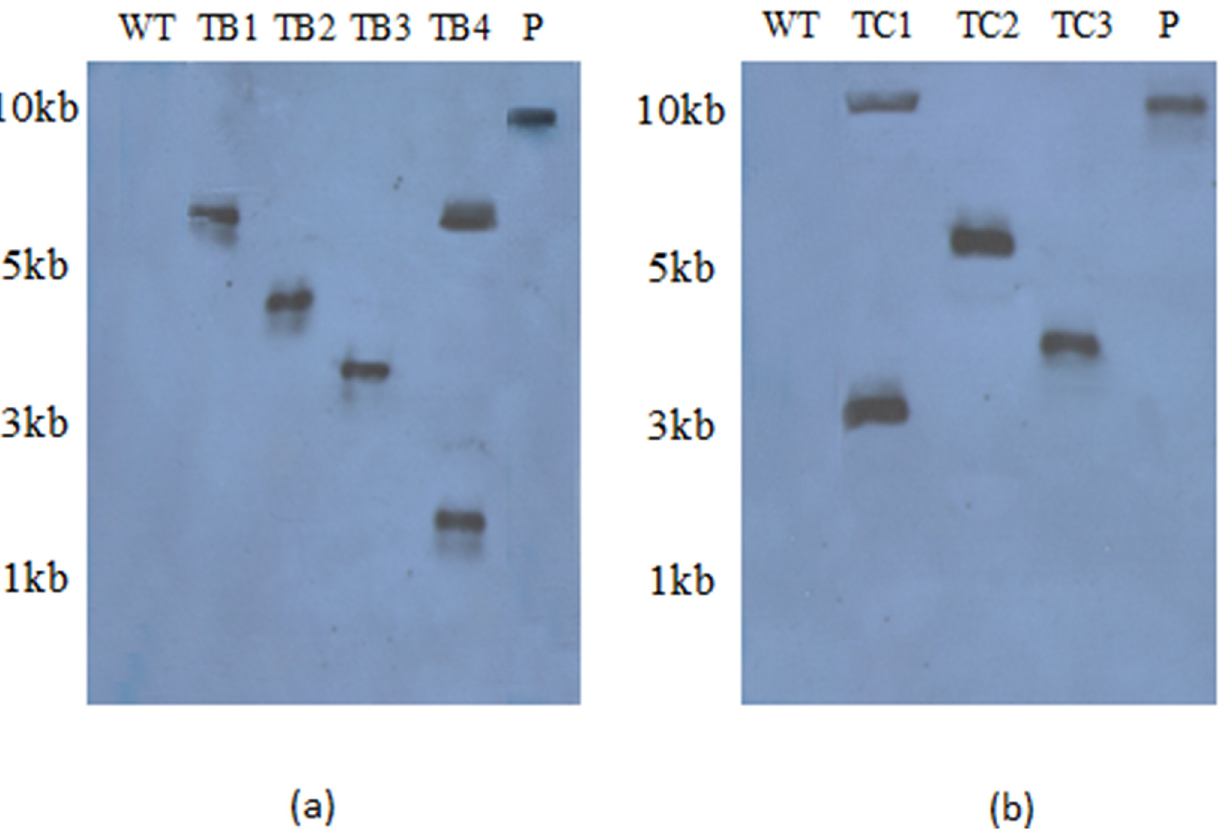
Fig 7. Southern blot analysis. Southern blot analysis of rol B (a) and rol C transgenic lines (b). TB1-TB4 represents rol B transgenics whereas TC1-TC3 represent rol C transgenics. Whereas "P ” stands for the plasmid DNA run as positive control. WT indicates the wild type